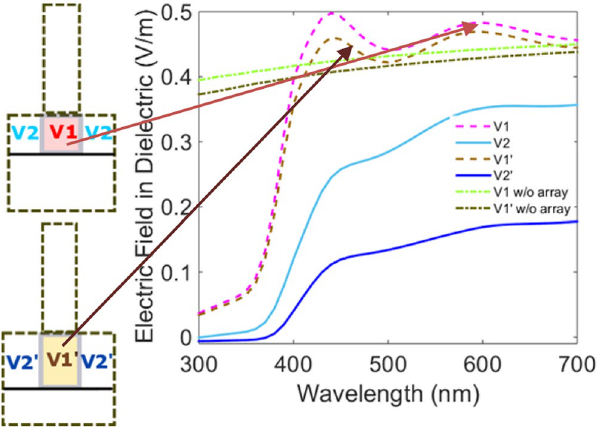
Figure 12. Electric field in regions below and between the rods in the underlying dielectric in comparison with the bare interface. The adjacent configurations shows regions where the field strengths are evaluated for the ZnO rod array (radius 60 nm, length 600 nm and pitch 200 nm). V1 corresponds to the volume inside the dielectric underneath the rod with a depth of 200 nm and V2 corresponds to the volume in the dielectric on either sides of the volume V1 with the same depth. V1’ corresponds to the volume inside the dielectric underneath the rod with a depth of 300 nm and V2’ corresponds to the volume on either side of the volume V1’ with the same